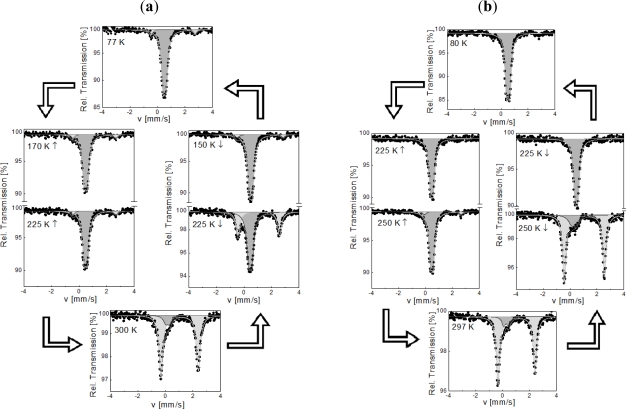
57Fe Mössbauer spectra cycles for 1·0.5H2O (a) and 1 (b) at selected temperatures. Grey and dark grey correspond to the high-spin (HS) and low-spin (LS) doublets, respectively.